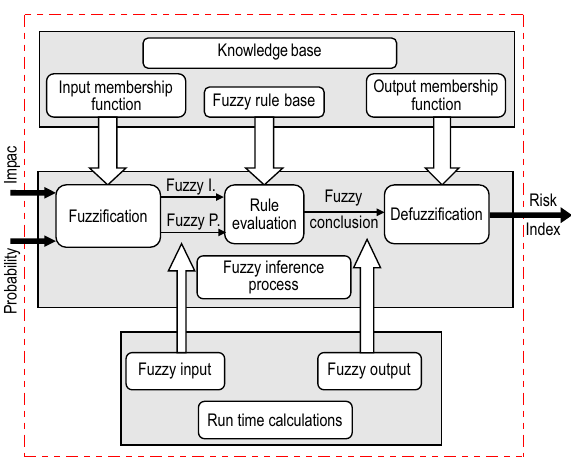
Fig. 2. Overall view of the fuzzy risk assessment